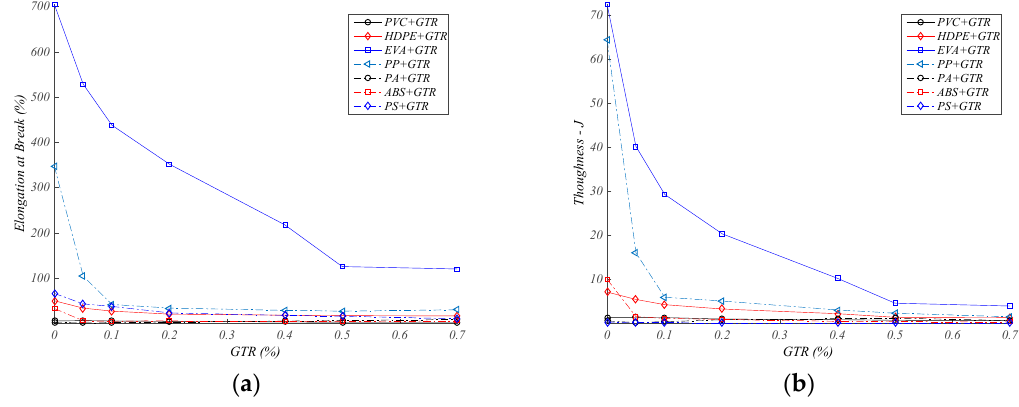
Figure 7. ( a ) Elongation at break (%), ( b ) toughness (J) for seven polymers/GTR concentrations and particle size <200 μ m.